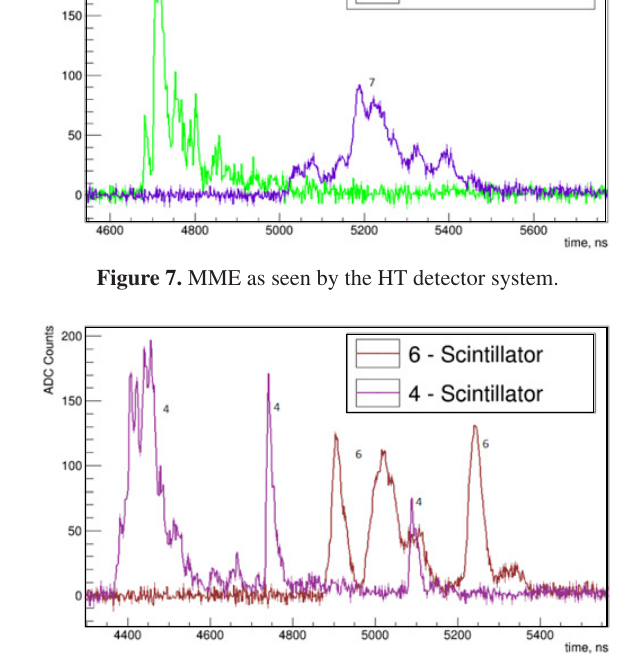
Figure 8. MME as seen by the HT detector system.